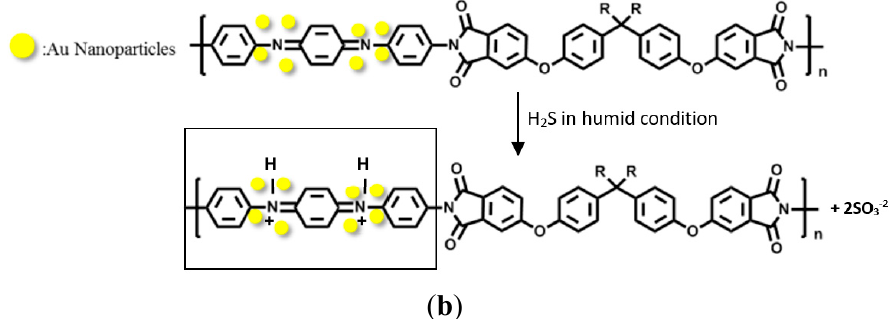
Figure 6. ( a ) Calibration plot obtained after the electroactive PI / AuNPs-based chemiresistor sensor was exposed towards increasing concentrations of H 2 S gas at RT (n = 3); and ( b ) the proposed sensing mechanism.